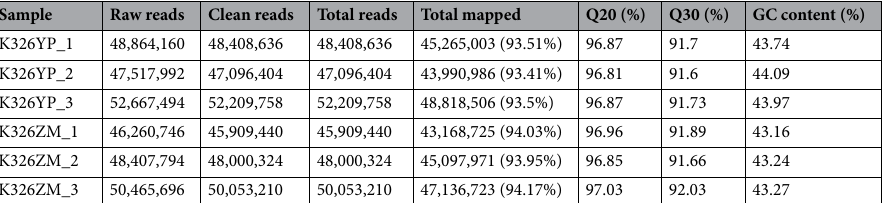
Table 2. Statistics of sequencing data